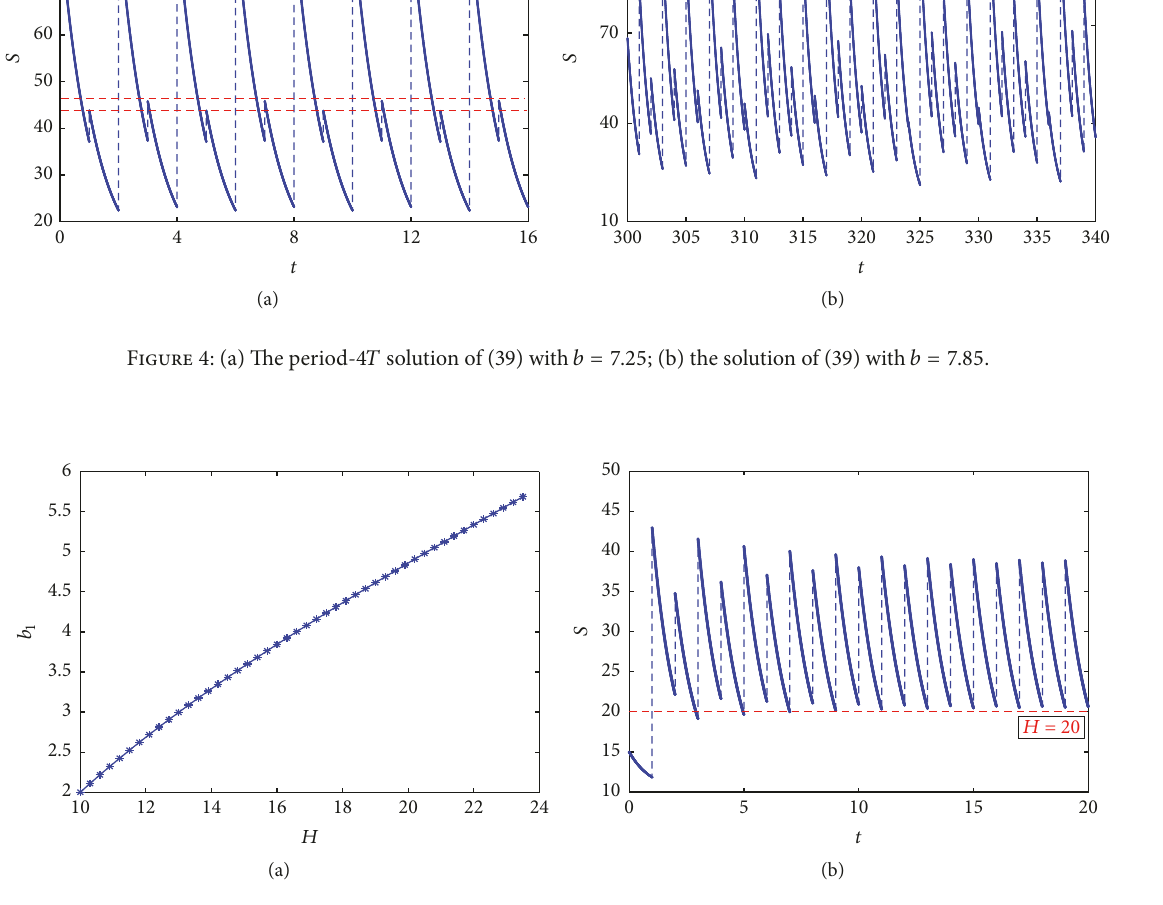
Figure 5: (a) The value of 𝑏 1 for 𝐻 ∈ (10, 23.5) ; (b) the solution of (39) with 𝑏 = 5 and the initial point (0,15) .